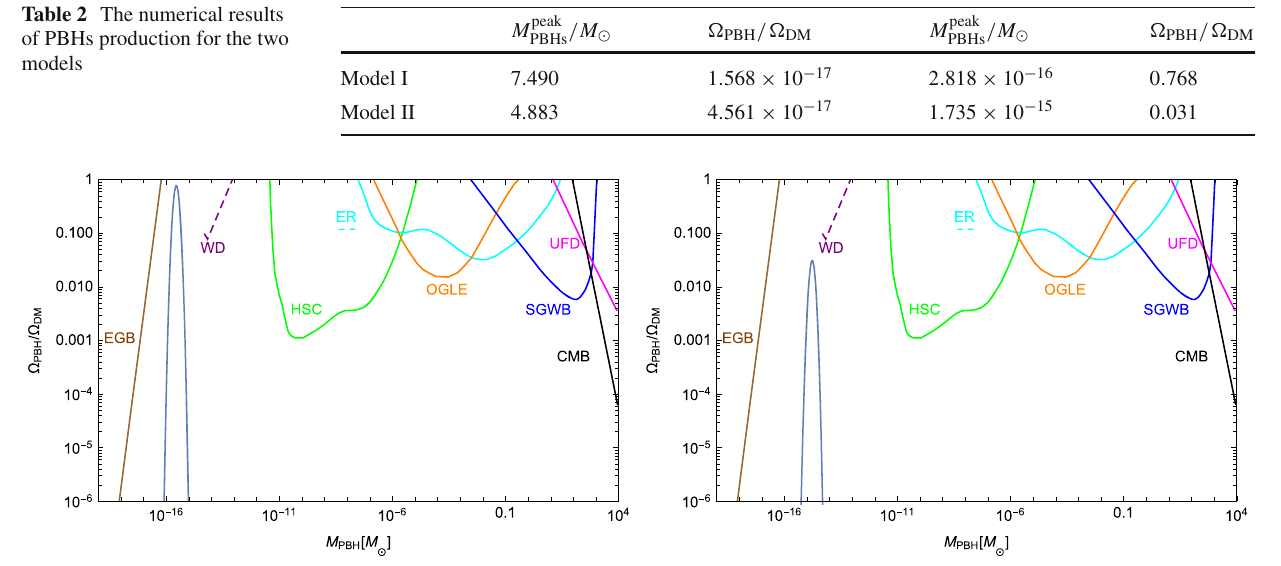
Fig. 6 The abundance of PBHs produced in Model I for parameter set (20) (left panel), and in Model II for parameter set (23) (right panel). The curves in the upper part are the observational constraints on the PBH abundance, which are taken from Ref. [80]